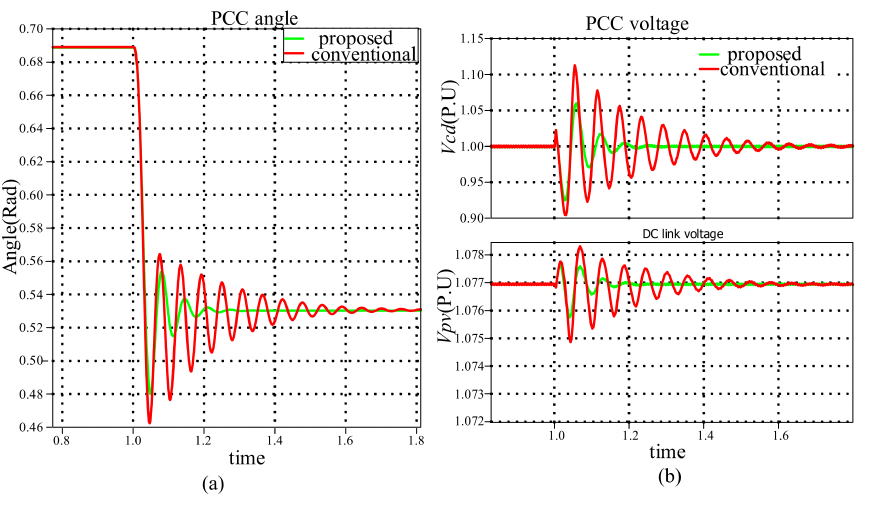
Figure 16. ( a ) PCC voltage angle and ( b ) v dc and v cd response when grid inductor change from 4.5 mH to 5.15 mH.